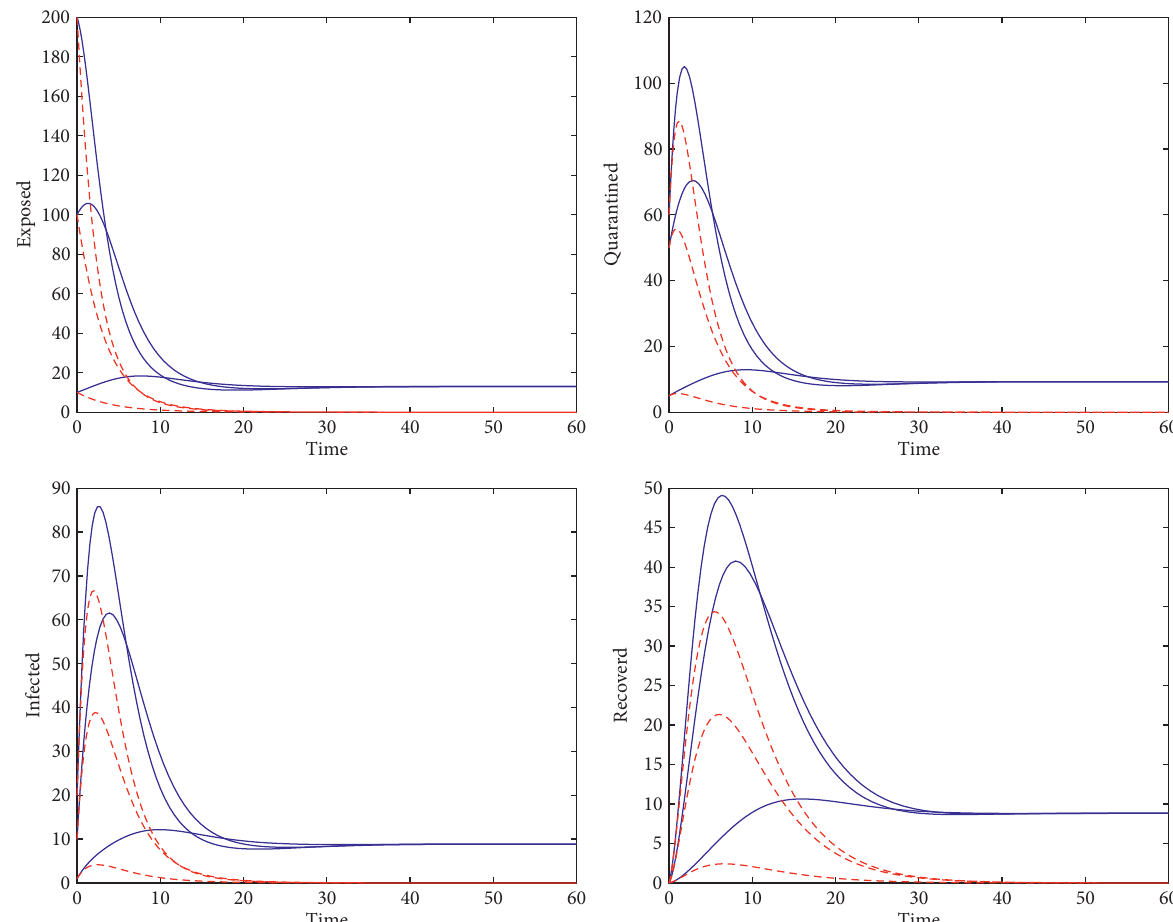
Figure 1: The local asymptotic stability of the equilibria of system (1). The blue line is the case of R R < 1. 0